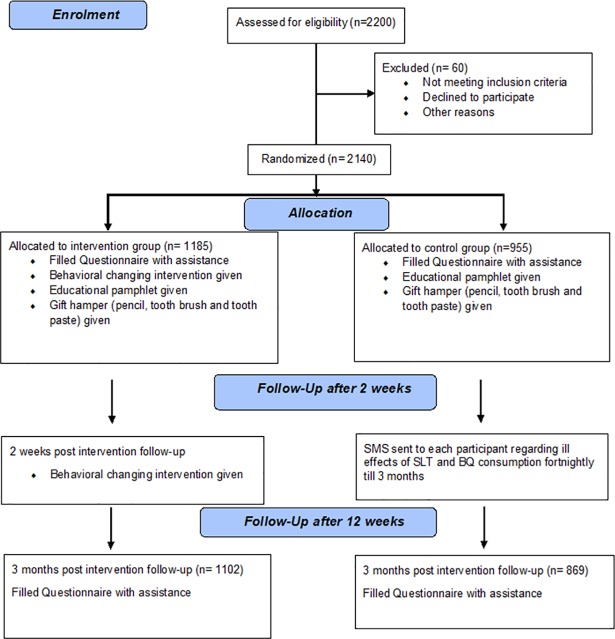
CONSORT flow diagram: Enrolment, allocation, and follow-up[24].